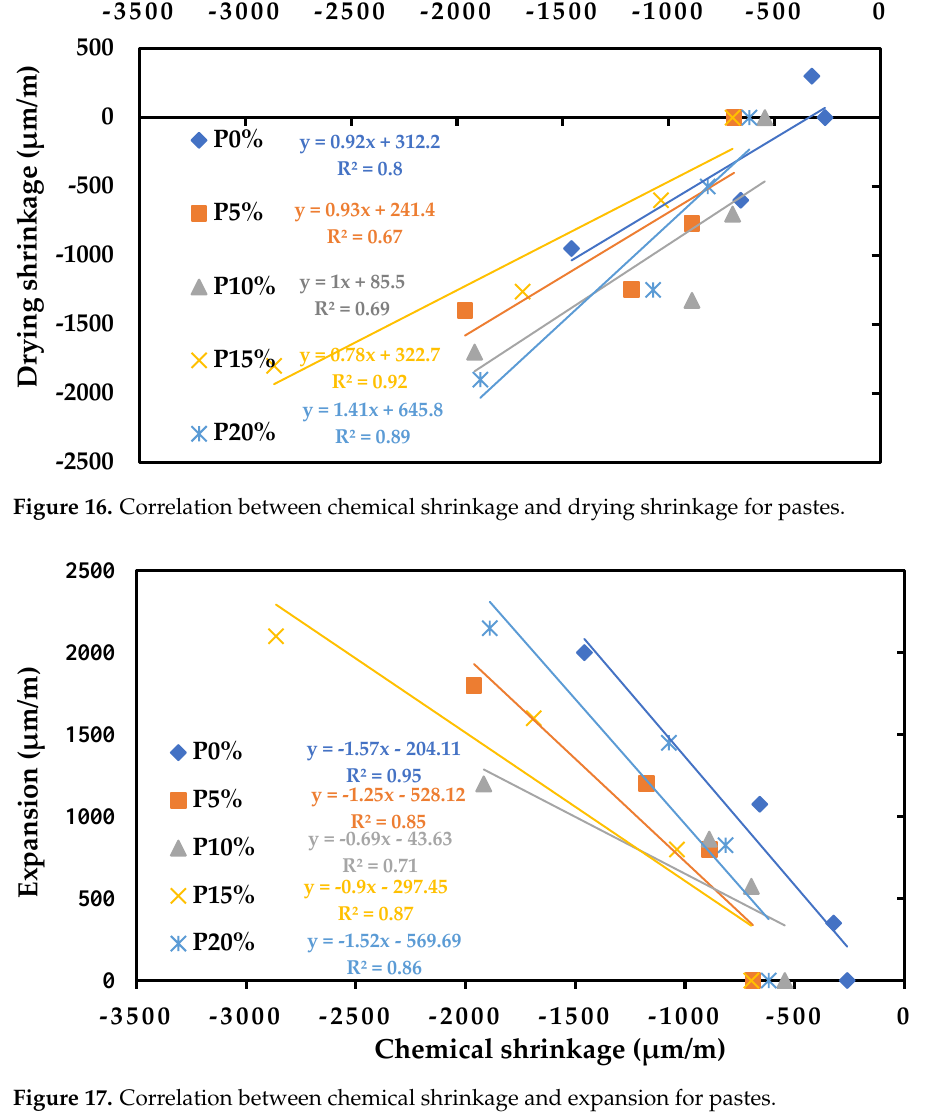
Figure 17. Correlation between chemical shrinkage and expansion for pastes.